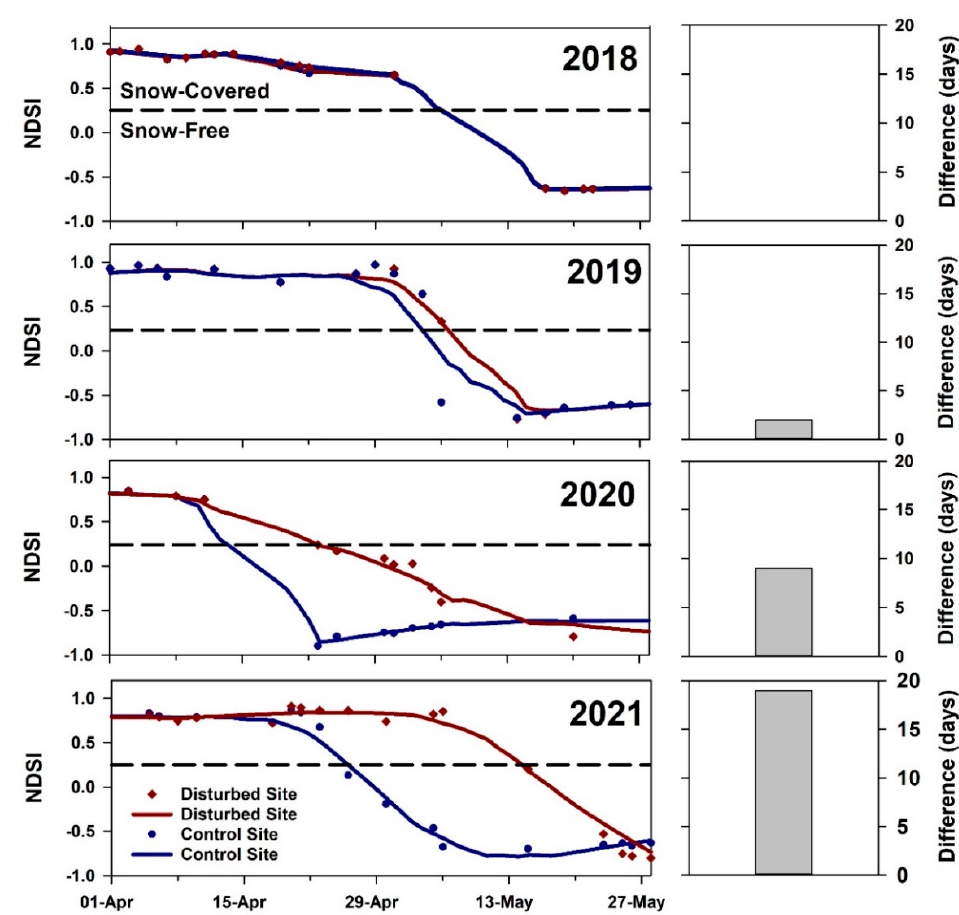
Figure 9. NDSI data derived from a time series of Sentinel-2 satellite imagery acquired between 2018 and 2021 for a control site (blue dots and lines) and a site within the beaver-induced permafrost degradation feature area (red dots and lines). The color-coded dots indicate single-pixel, individual NDSI values from a particular Sentinel-2 image (location shown in Figure 3), while the color-coded lines represent the time integrated NDSI value for each site for each year based on LOESS smoothing using a 1st order polynomial. Blowing and drifting snow now accumulates in a thaw-affected depression during the winter, increasing the snow depth relative to the control site, and resulting in a longer snow-melt period for areas affected by permafrost degradation. The difference in snow-melt date between the control and disturbed site was 19 days in 2021, compared to 0 in 2018, prior to the beaver-induced fluvio-thermal erosion and thermokarst feature development.